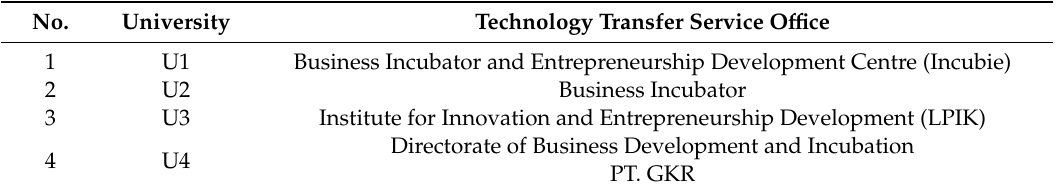
Table 4. List of technology transfer service o ffi ces.